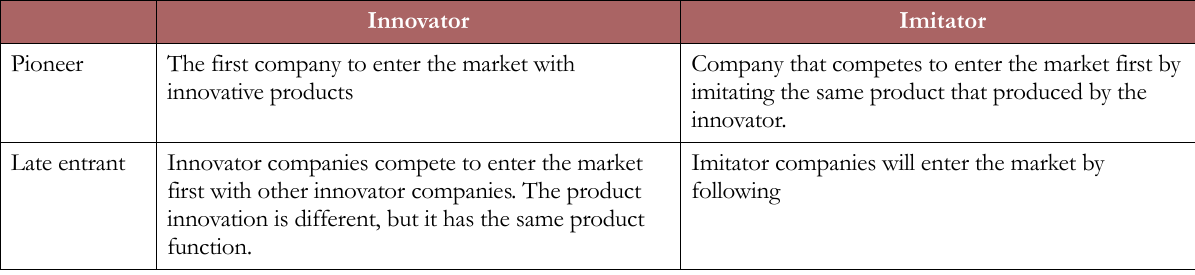
Table 1. Imitation and Market Entry